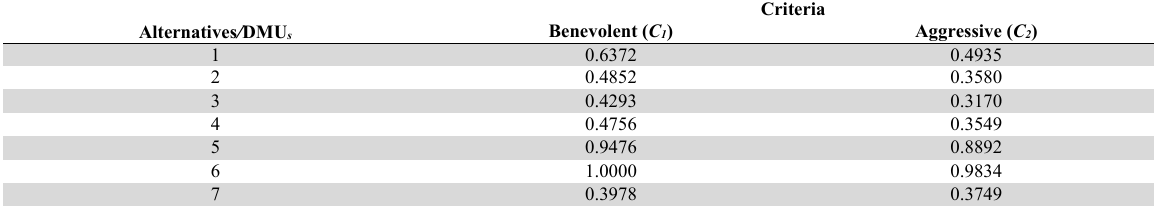
Decision matrix of seven biomass fuel